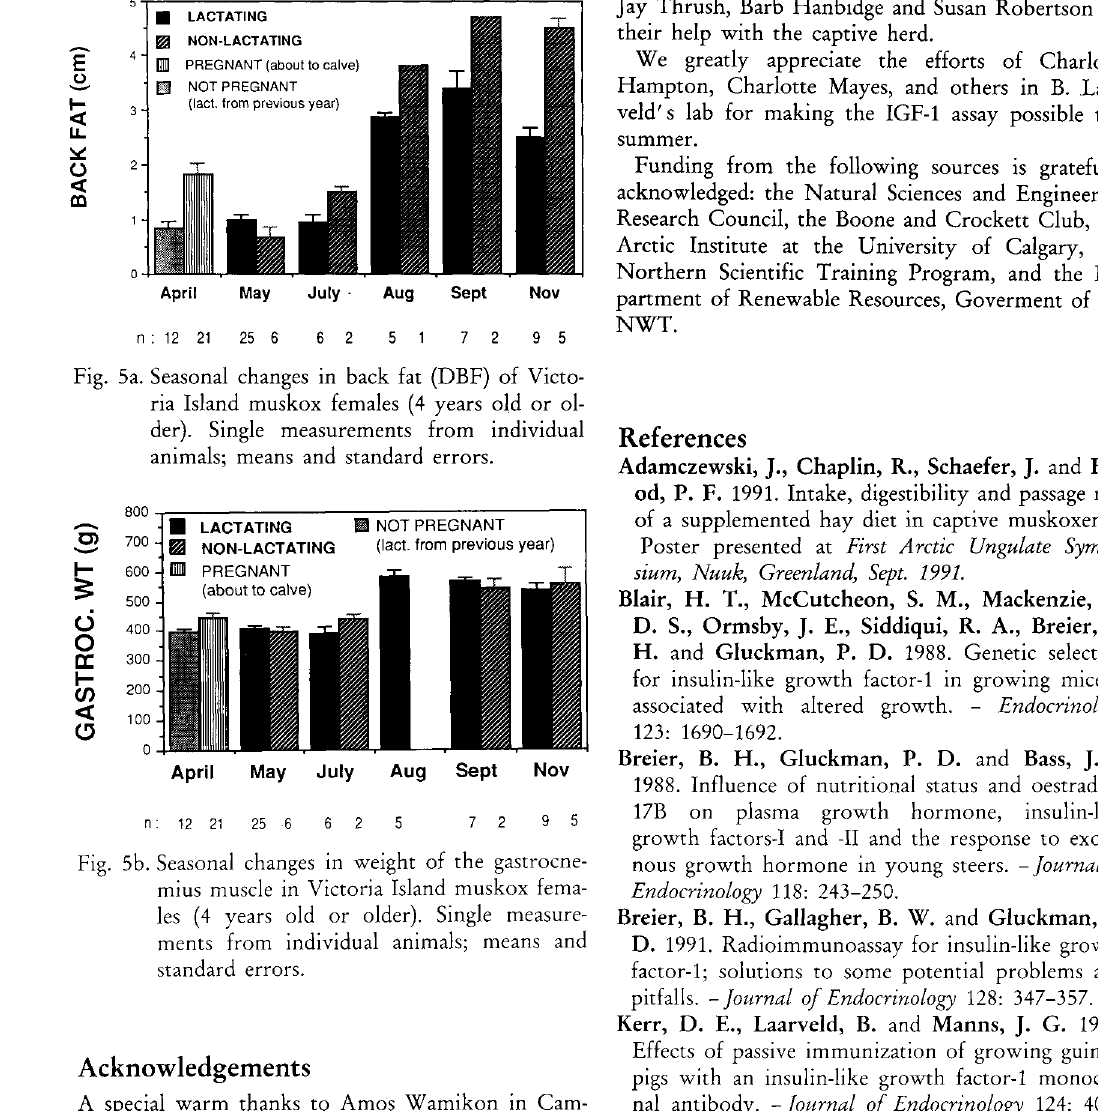
Fig. 5a. Seasonal changes in back fat (DBF) of Victo ria Island muskox females (4 years old or ol der). Single measurements from individual animals; means and standard errors.